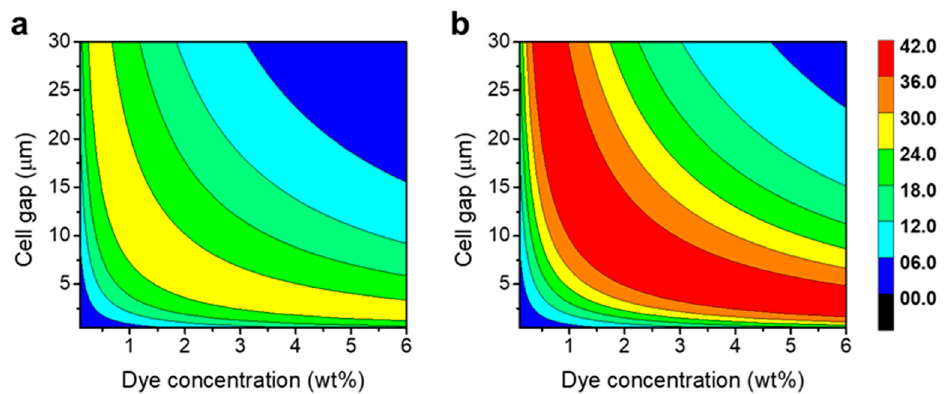
Figure 5. The constant transmittance-difference contour maps of ( a ) ECB and ( b ) ChLC cells on the parameter space of the cell gap and dye concentration.